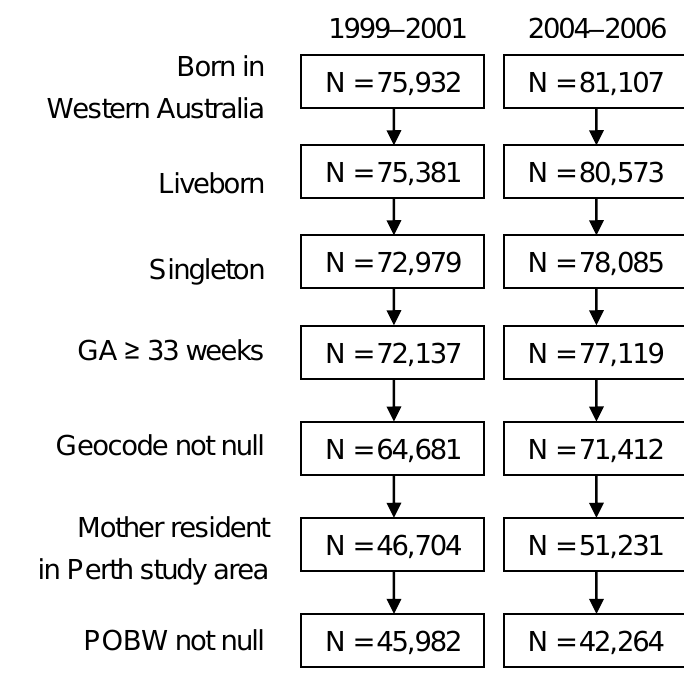
Figure 1. Selection of records for the two study